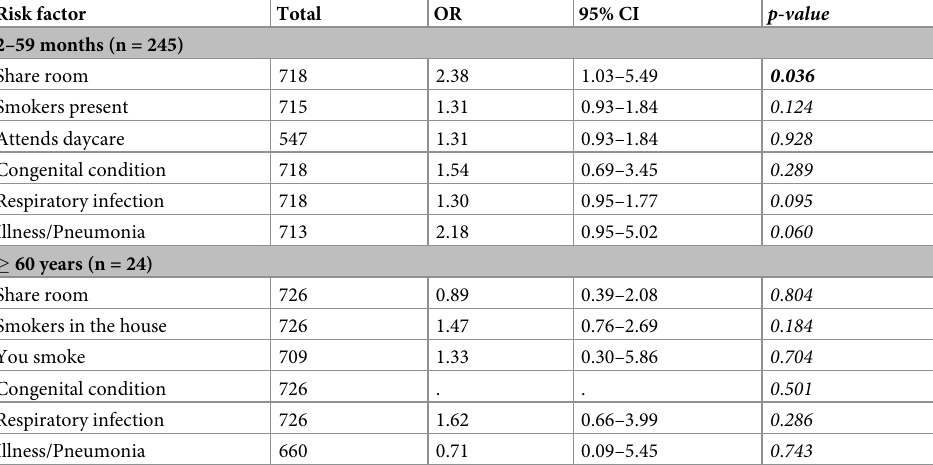
Table 2. Association between risk factors and nasopharyngeal colonization with S . pneumoniae , according to age group. Risk factor